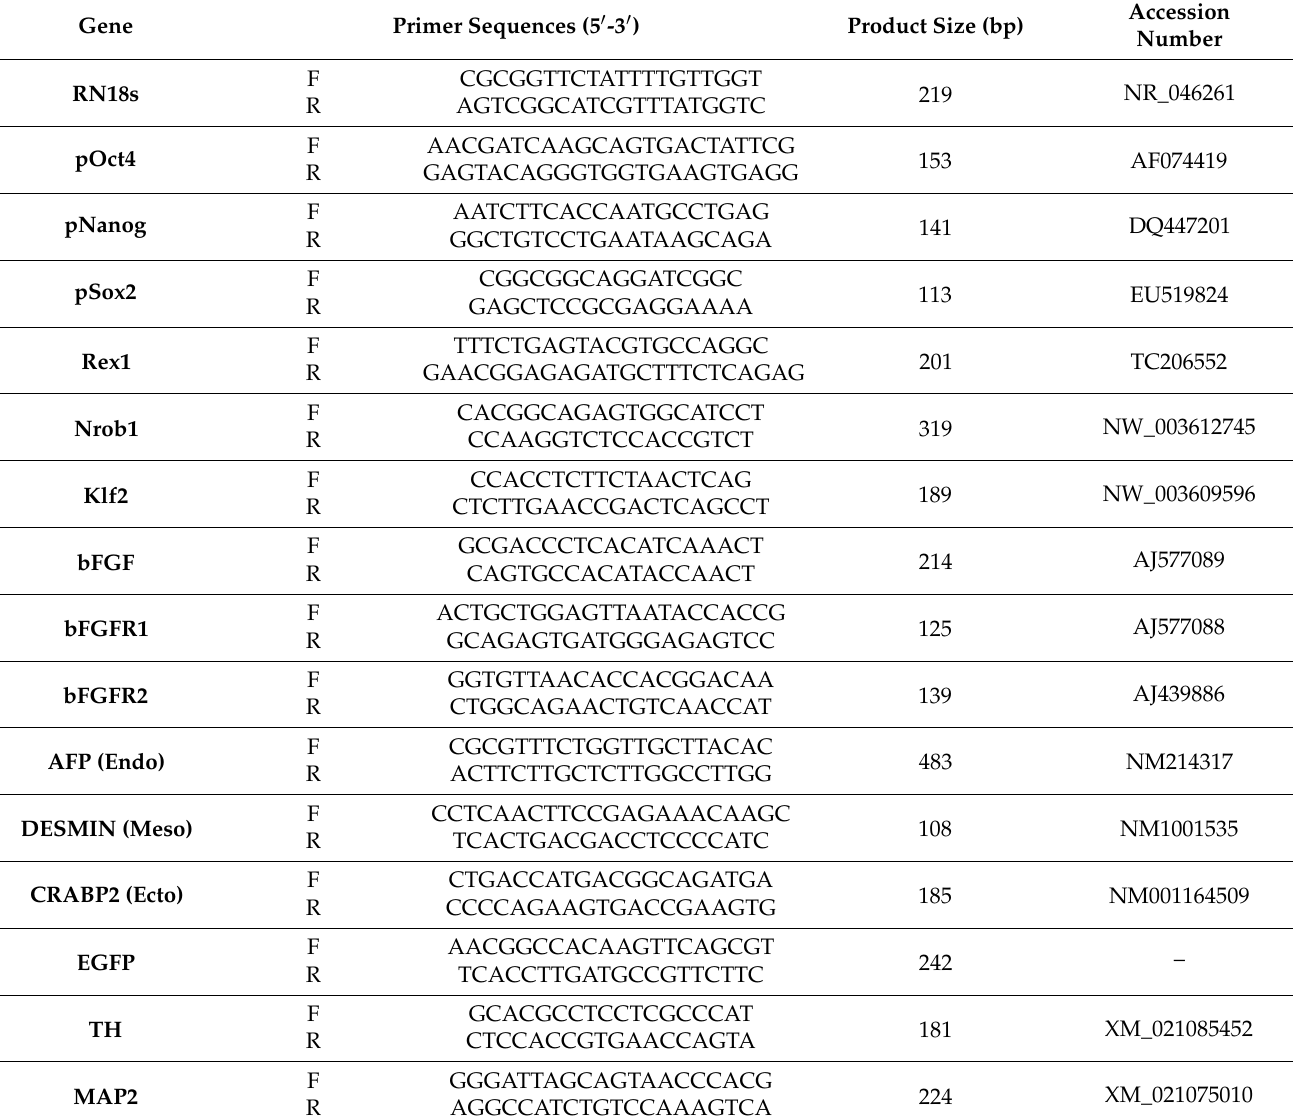
Table 2. Primer sequences used for gene analysis using